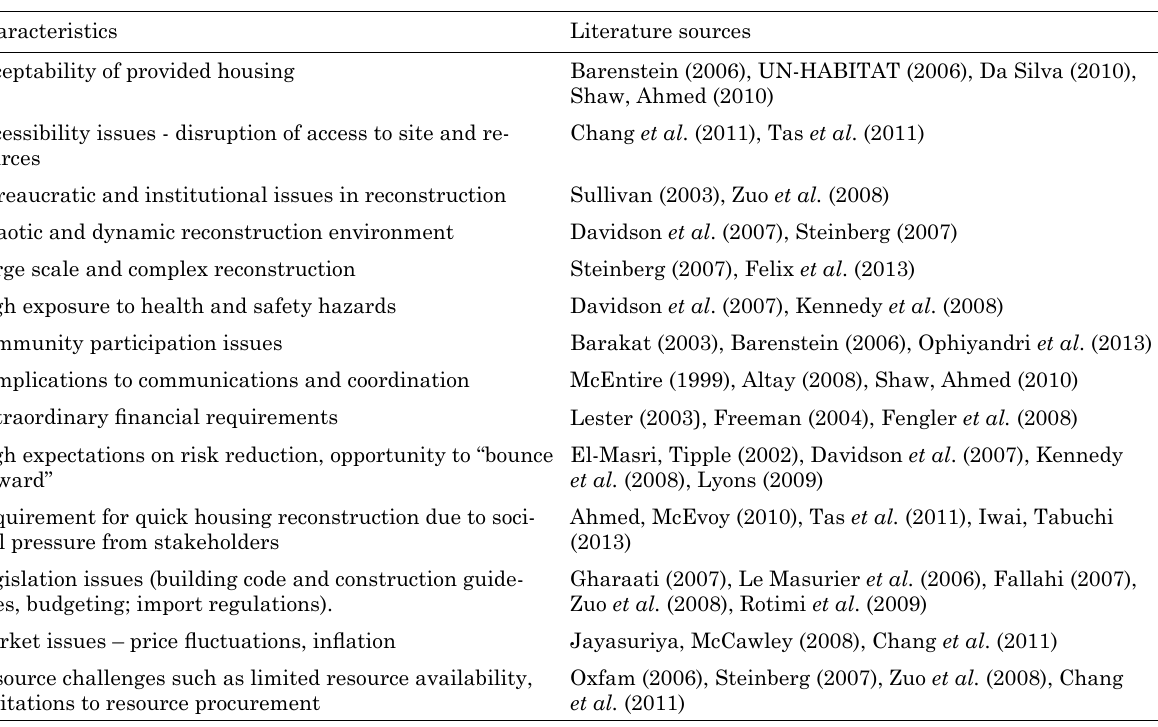
Table 1. Characteristics of the post-disaster reconstruction context